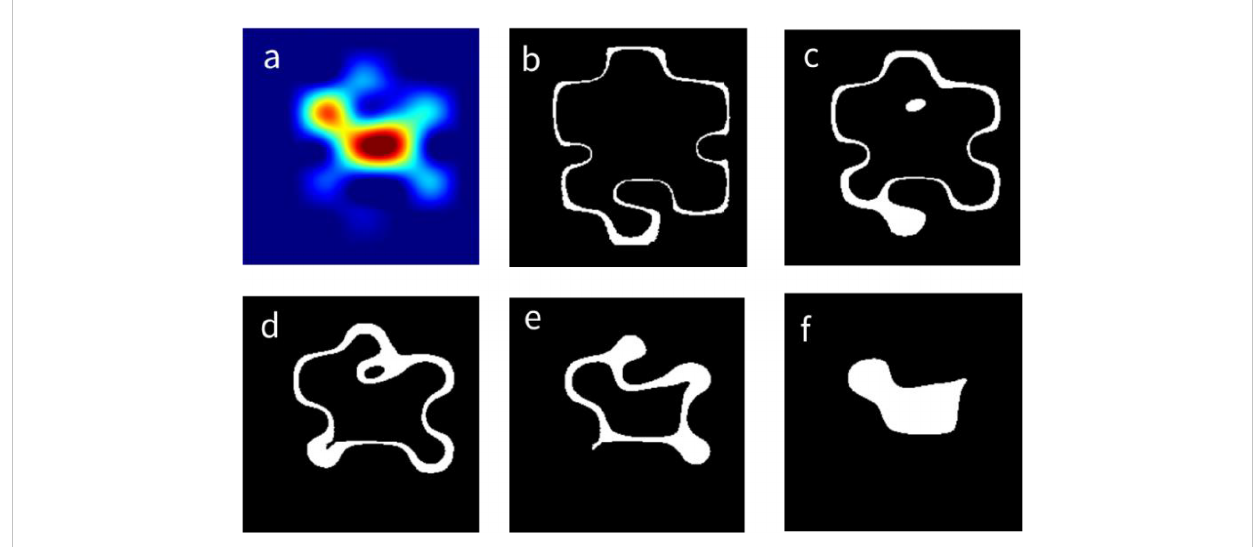
FIGURE 2 Division of a CAM into fi ve equal parts. (A) The CAM of a thyroid nodule. (B – F) The segmented region from the outermost region (labeled as region I) to the innermost region (labeled as region V), respectively. CAM, class activation map.